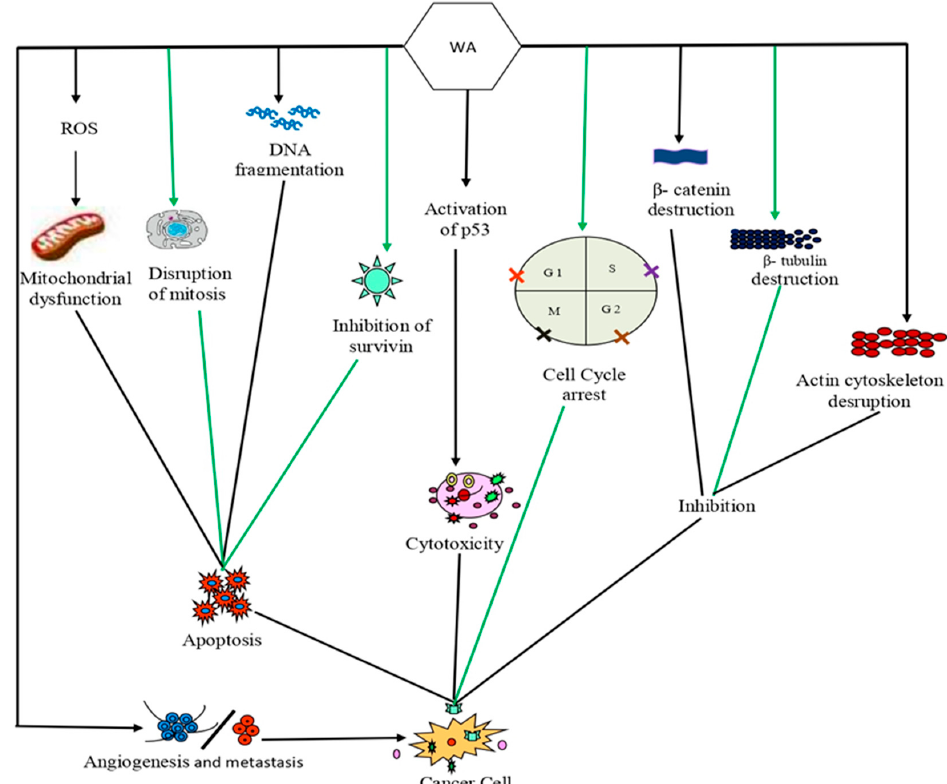
Figure 2. Mechanism of action of withaferin A against cancer cells: Withaferin A caused dysfunction of mitochondria and disruption of mitotic spindle assembly of cancer cells by producing excessive ROS that can lead to apoptosis. Withaferin A can also inhibit the activities of β catenin and β tubulin and can disrupt the actin cytoskeleton. Activation of p53 function through withaferin A leads to apoptosis in cancer cells. Withaferin A also increased the rate of apoptosis in cancer cells by reducing the levels of antiapoptotic genes/proteins, such as Bcl-2 and B-Bcl-xL. Abbreviations: Bcl-2, B-cell lymphoma 2; Bcl-xL, B-cell lymphoma-extra-large; ROS, reactive oxygen species. Mckenna et al. [132] found that withaferin A decreased the activation of NF- κ B and Table 1. Anticancer effects of withaferin A based on selected in vitro attenuated the level of proteins engaged in B-cell receptor signaling and regulation of the cell cycle. Additionally, withaferin A increased the expression level of Hsp70 by inhibiting Hsp90 protein activity in murine and human B-cell lymphoma cell lines. Another study also demonstrated the inhibition of Hsp90 by withaferin A in a pancreatic cancer cell line through the degradation of Akt, cyclin-dependent kinase 4 Cdk4, and a glucocorticoid